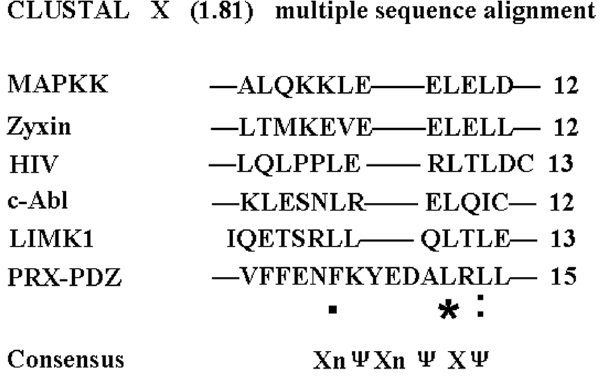
Figure 4. Alignment of potential NES sequences of L-periaxin with previously characterized leucine-rich NESs. NES sequences in mitogen-activated protein kinase kinase (MAPKK), zyxin, HIV.Rev, c- Abl, and LIM-kinase 1 are obtained from previous studies [22,29,30,31,32]. Residue numbers are indicated in parentheses. Consensus sequence is shown at the bottom. Y indicates hydrophobic residues, which include leucine, isoleucine, valine, phenylalanine, and methionine.